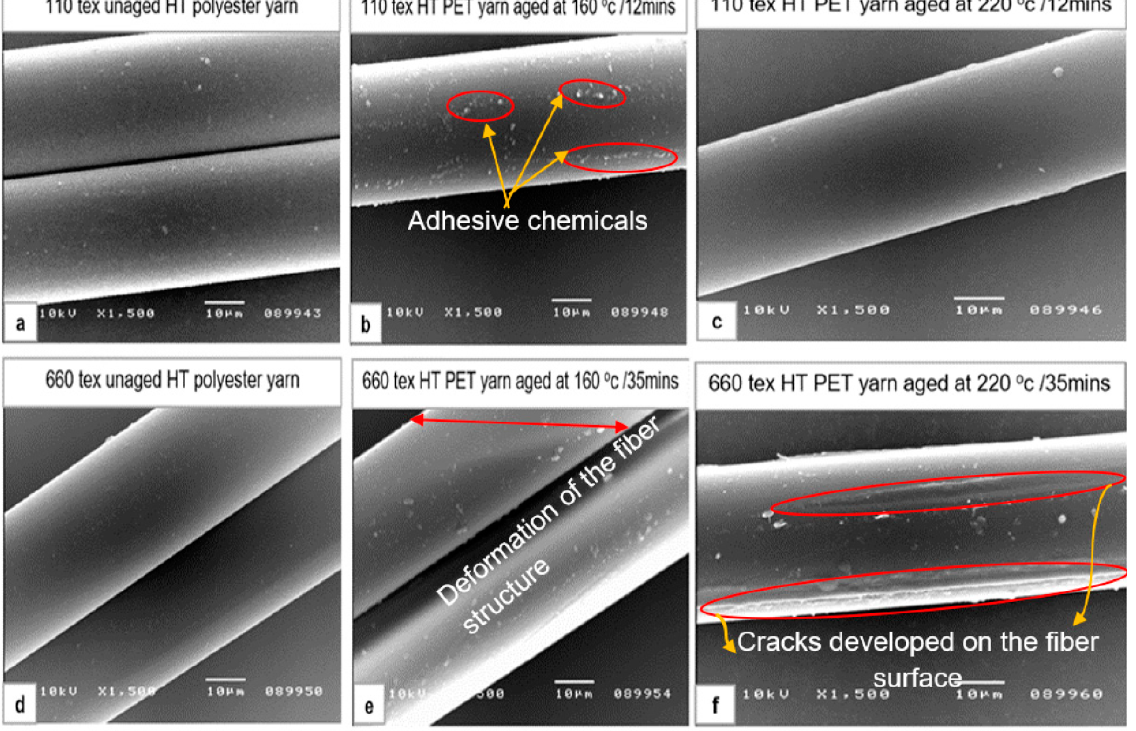
Figure 10. Surface structural view of high tenacity polyester fiber using scanning electron microscopy (SEM). ( a ) 110 tex unaged HT polyester yarn; ( b ) 110 tex HT polyester yarn aged at 160 ◦ C for 12 min; ( c ) 110 tex HT polyester yarn aged at 220 ◦ C for 12 min; ( d ) 660 tex unaged HT polyester yarn; ( e ) 660 tex HT polyester yarn aged at 160 ◦ C for 35 min; ( f ) 660 tex HT polyester yarn aged at 220 ◦ C for 35